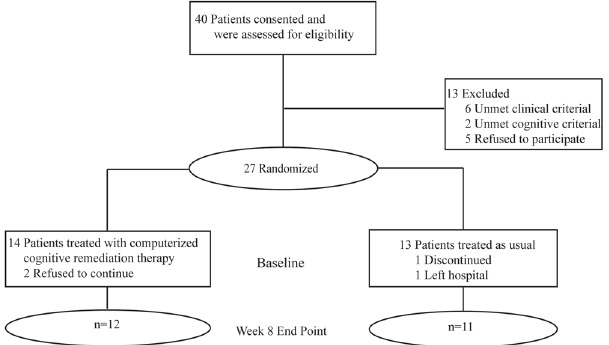
Figure 1. Consort